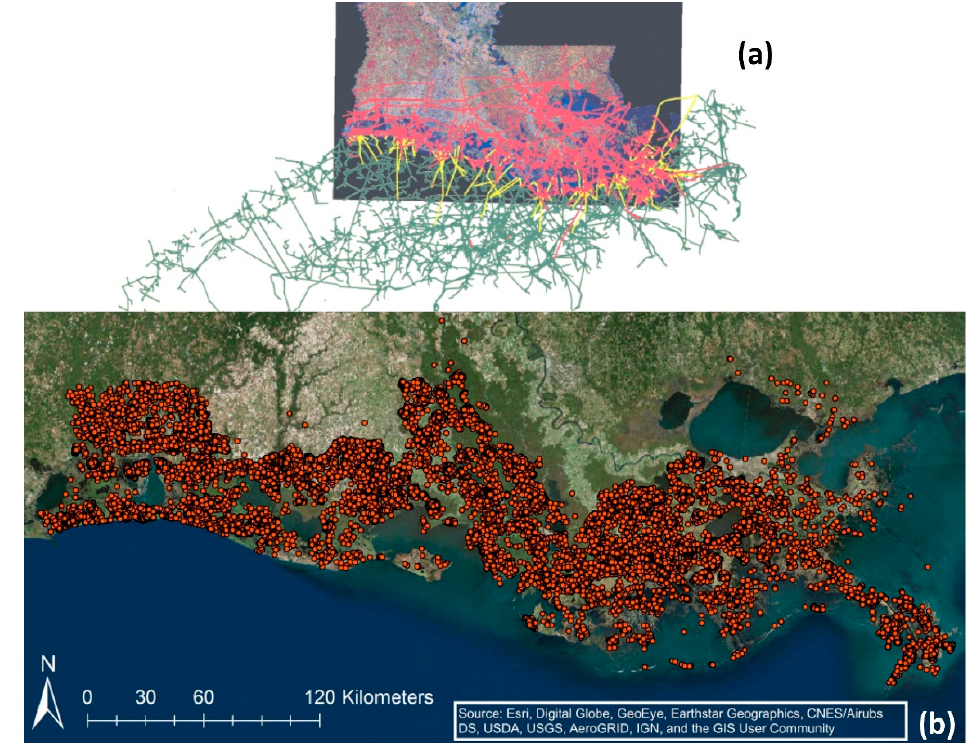
Figure 1. ( a ) Map of oil and gas pipelines in coastal Louisiana (http://www.dnr.louisiana.gov/assets/docs/oilgas/data/SLA_Pipelines.pdf) and ( b ) the distribution of oil and gas well permits issued between 1900 and 2017 that were ‘plugged’ or ‘abandoned’ as of 2017 in the 14 coastal parishes [18].